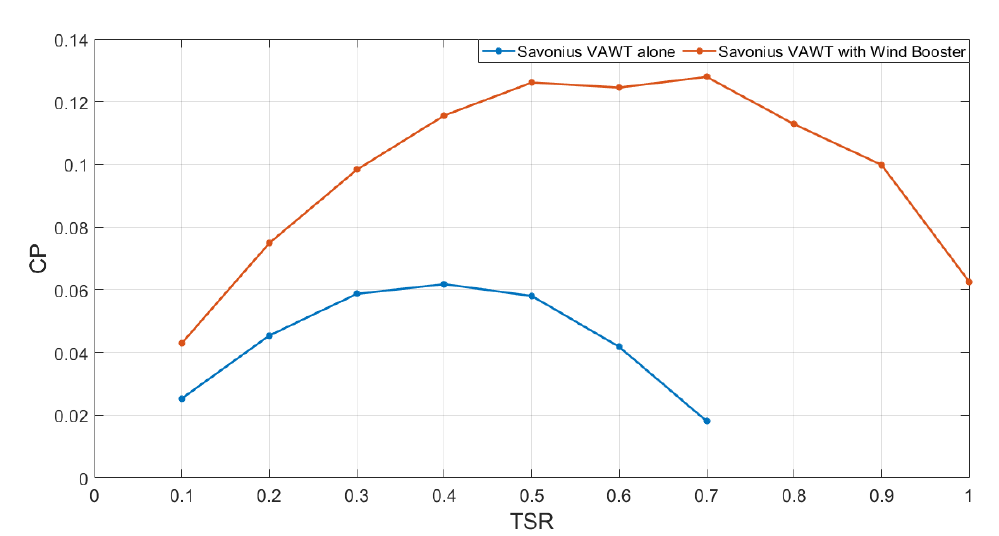
Figure 17. Performance improvement of the VAWT with the designed Wind Booster.